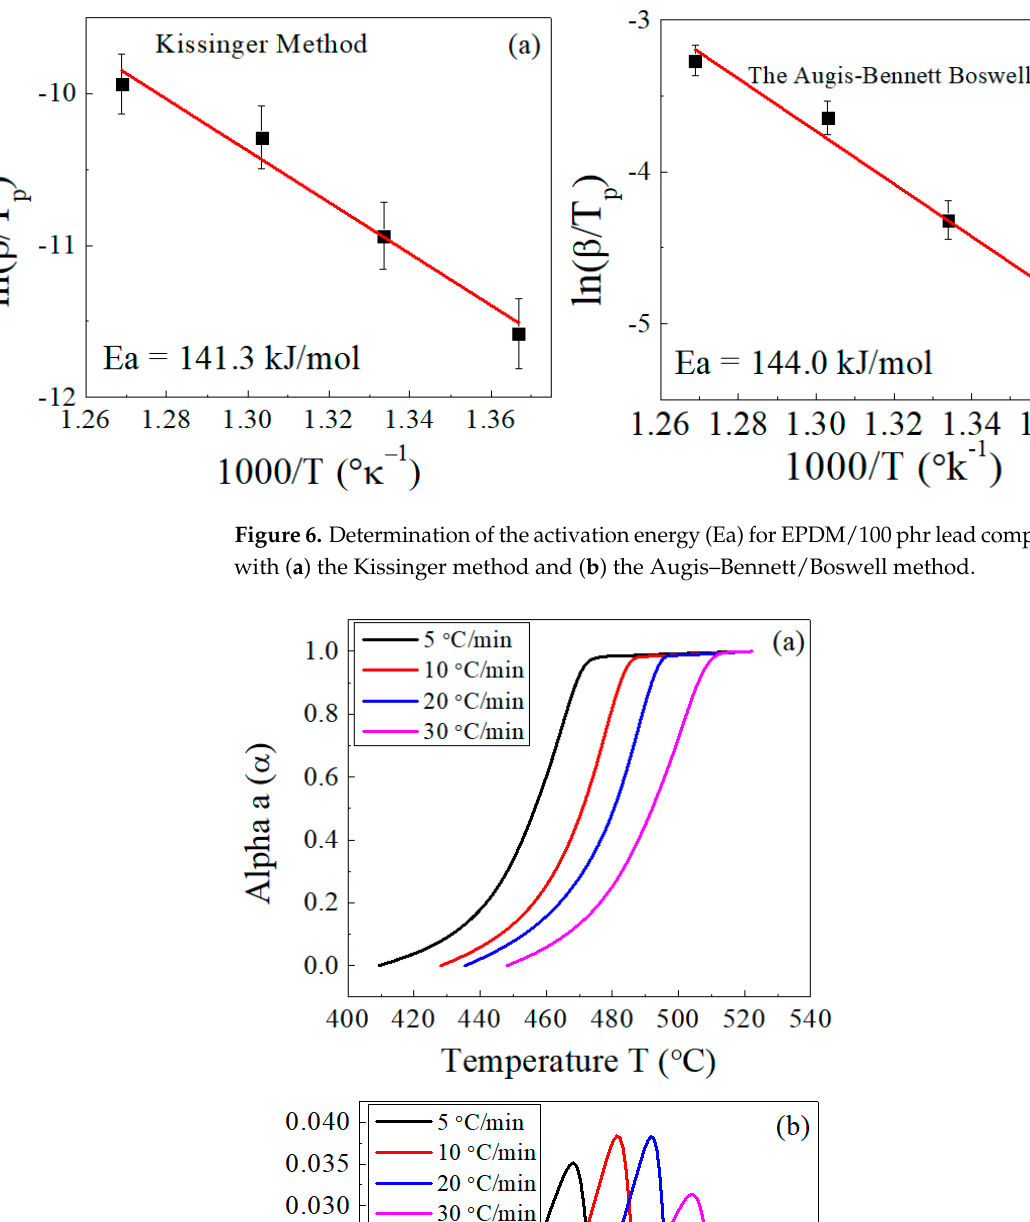
Figure 6. Determination of the activation energy (Ea) for EPDM/100 phr lead composite in ac- cordance with ( a ) the Kissinger method and ( b ) the Augis–Bennett/Boswell method.